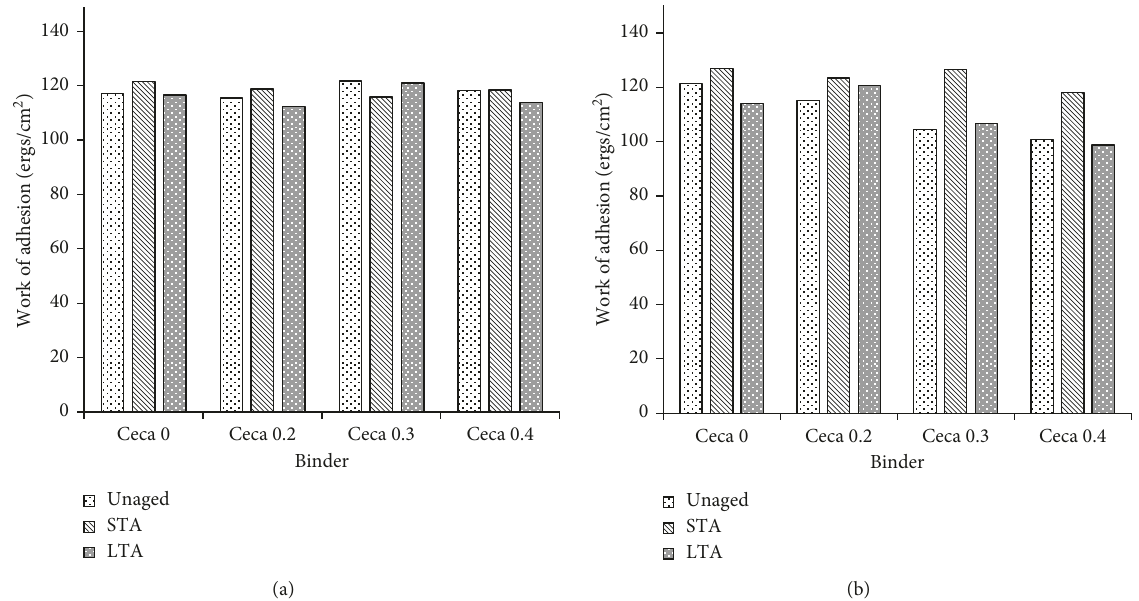
Figure 9: Work of adhesion energy of PG-76 asphalt binder: (a) limestone; (b) granite.